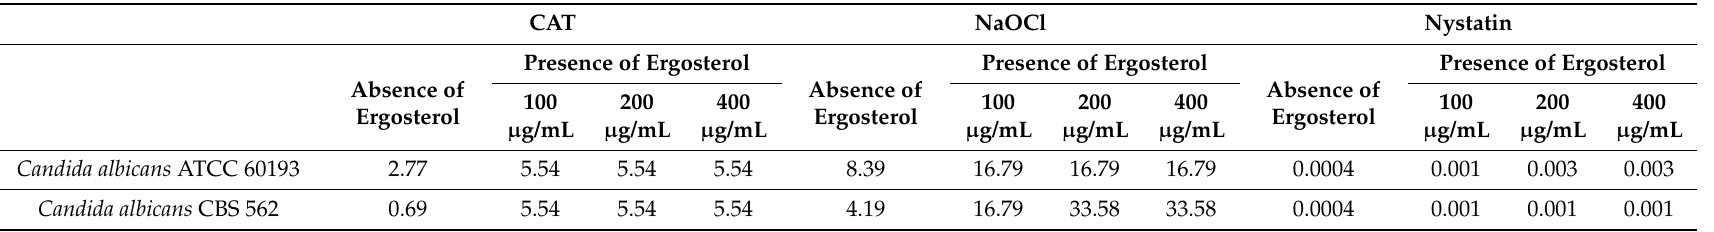
Table 3. Effects of different concentrations of exogenous ergosterol on the MIC of chloramine T (CAT), sodium hypochlorite (NaOCl) and nystatin against C. albicans strains. Values are expressed in